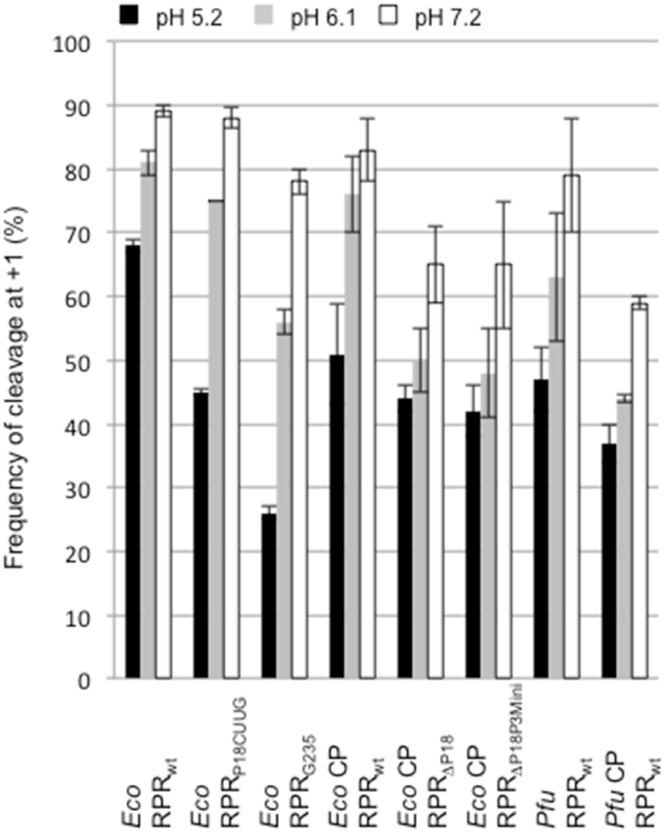
Frequency of cleavage of pATSerUamG at the +1 position with different RPRs at different pH as indicated.Reactions were done under single turnover (substrate concentration ≤0.02 μM) conditions at 37°C in buffer C at 800 mM Mg2+ as described elsewhere ([37, 38]; see also Materials and methods). The concentrations of RPRs were (reaction times in parenthesis): Eco RPRwt 0.8 μM (10 min), Eco RPRP18CUUG 0.8 μM (10 min), Eco CP RPRwt 11 μM (270 min), Eco RPRdelP18 12 μM (270 min), Eco RPRdelP18P3Mini 14.5 μM (270 min), Pfu RPRwt 4.5 μM (60 min) and Pfu CP RPRwt 20 μM (270 min). The plots are based on four independent experiments and the bars indicate experimental errors.